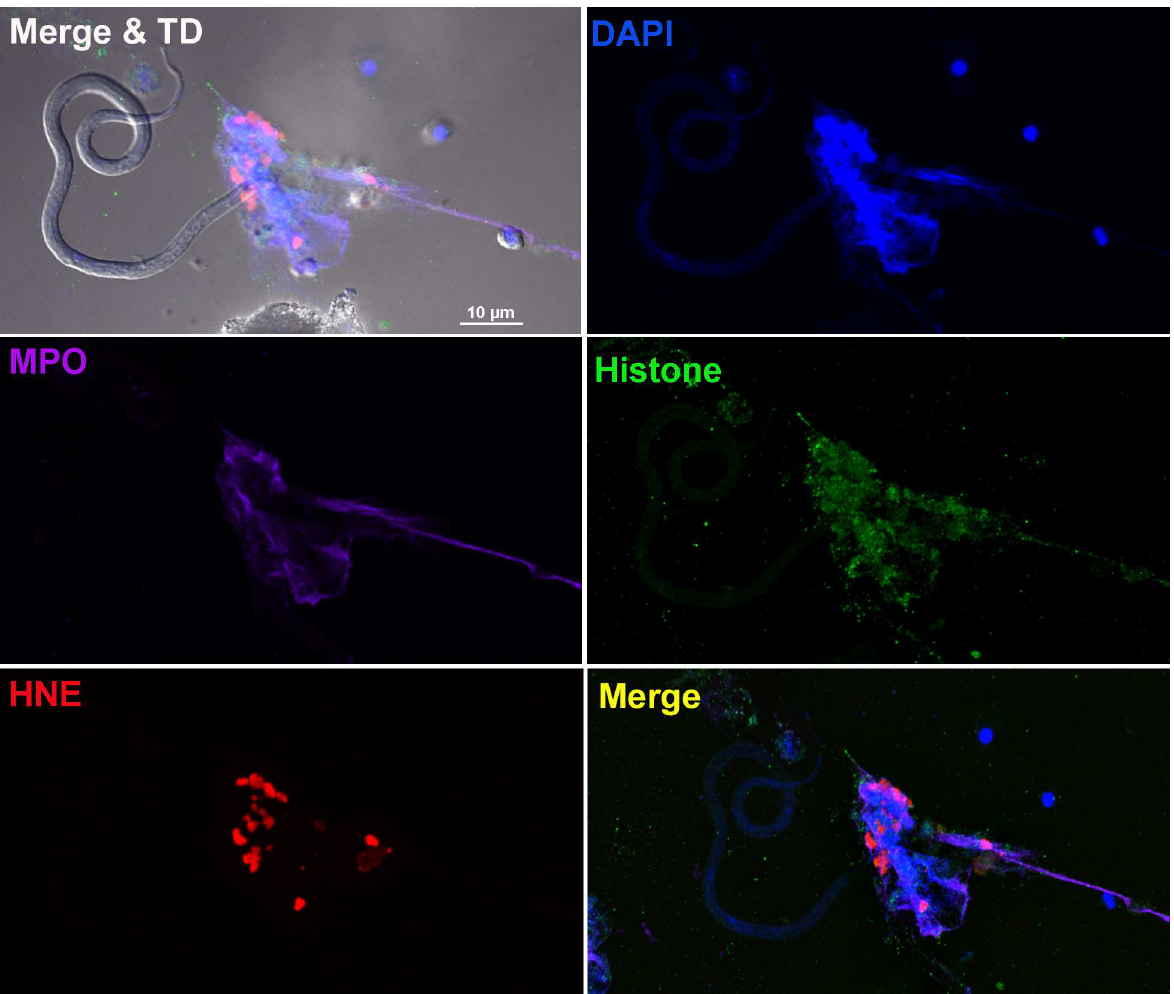
Fig 1. B . malayi Mf entangled within neutrophil extracellular traps. Fluorescence imagingof a worm-NET aggregatelabelledwith DAPI (blue) and antibodies to myeloperoxidase(MPO; purple), citrullinatedhistoneH4 (histone; green) and human neutrophil elastase (HNE; red). The co-localization of markers with Mf is shown in the merged image with transmitted light (top left panel)and the overlapof MPO, histoneand HNE with DNA shown in the mergedimage (bottom right panel). Live Mf were incubatedin the presenceof human neutrophilsfor 18 hours at 37˚C and 5% CO 2 . Scale bar = 10 μ